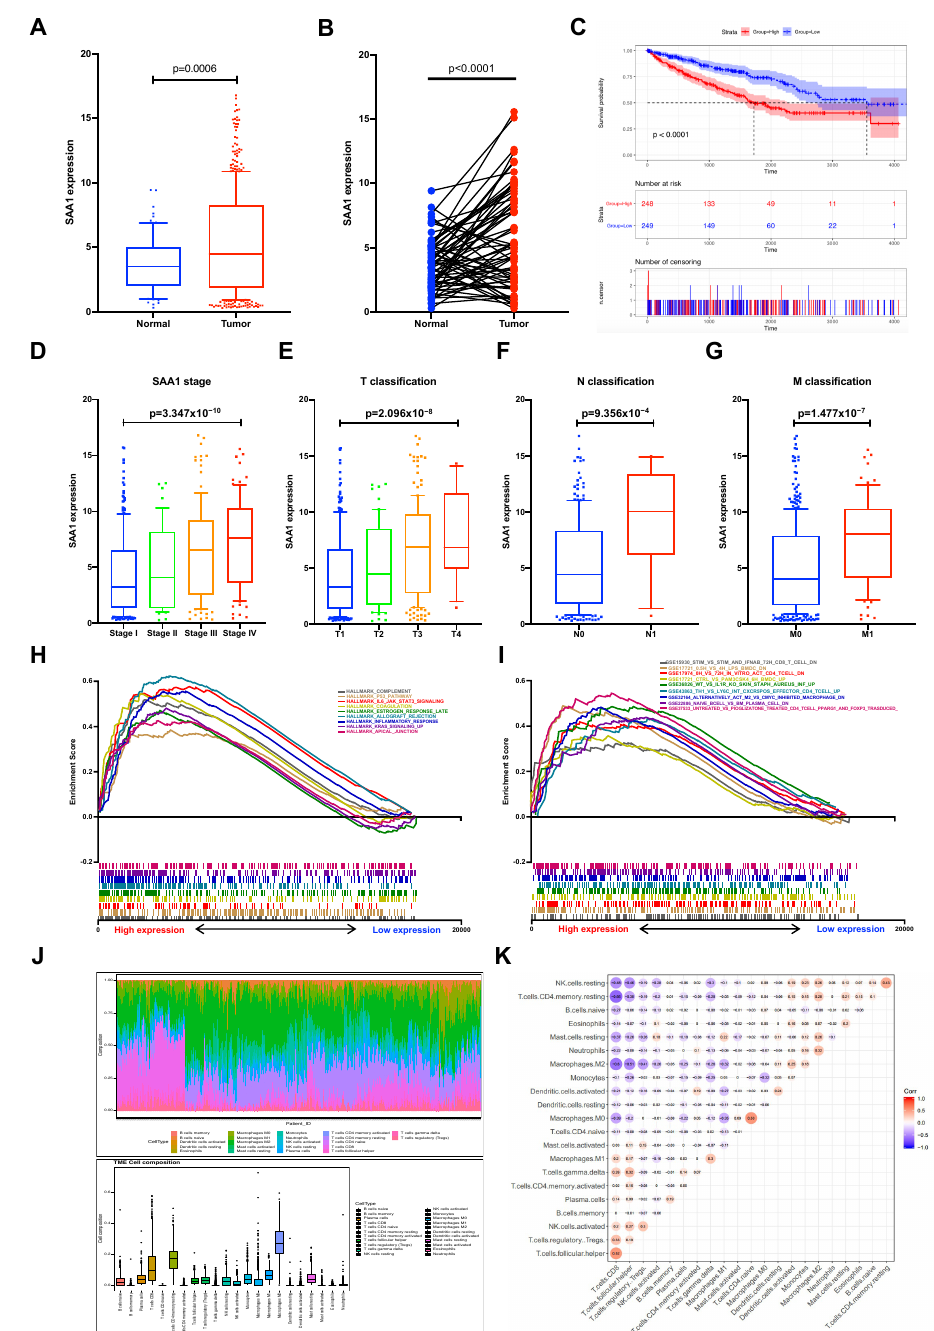
Figure 4. Correlation between survival and clinicopathological features of KIRC patients, GSEA, and TIC analysis. ( A ) Differential expression analysis of SAA1 between adjacent normal and ccRCC samples. ( B ) The differential expression analysis of SAA1 in matched normal-tumor pairs ( p < 0.0001). ( C ) Kaplan- Meier survival analysis for ccRCC patients with different SAA1 expression, p < 0.0001 by log-rank test. ( D – G ) The expression of SAA1 was positively correlated with tumor stage, T stage, N stage, and M stage. ( H ) GSEA results showed significant enrichment of immune-related signaling pathways in HALLMARK collection by high SAA1 expression ccRCC patients. ( I ) GESA results revealed enriched immunologic gene sets in C7 collection by high SAA1 expression KIRC patients. ( J ) Bar plot showed the proportion of each of the 21 kinds of TICs in ccRCC tumor sample. and TME cell composition in ccRCC tumor samples. ( K ) Correlation heatmap showing the correlation between the 21 kinds of